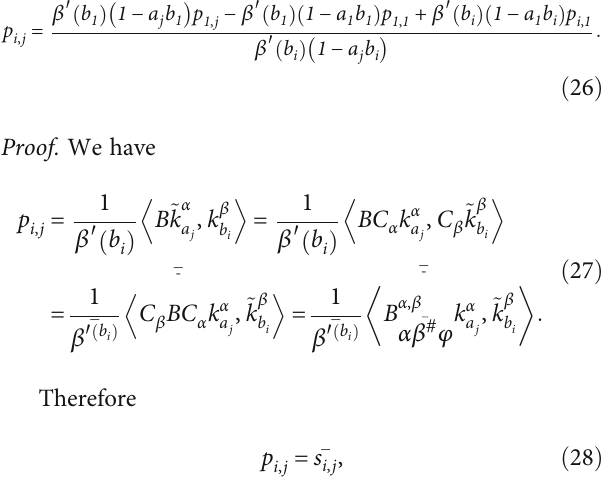
(cid:12) ð Þ (cid:12) 1 ffiffiffiffiffiffiffiffiffiffiffiffiffiffiffi (cid:12) β ′ ζ ð Þ (cid:12) i